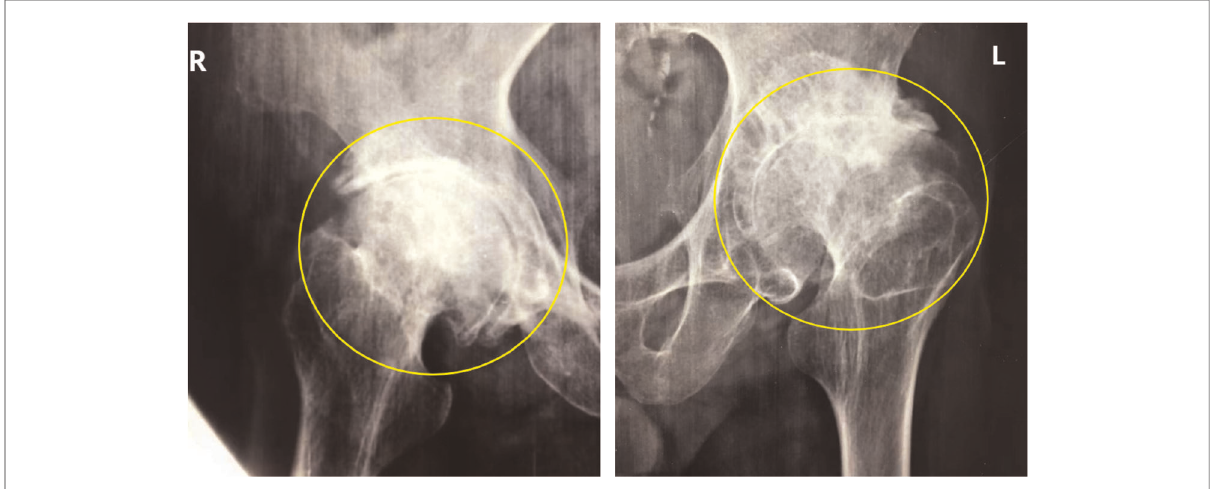
FIGURE 1 The patient ’ s preoperative x-ray of the hip joint. (Figure notes: Circles in the x-ray were marked to show that varying degrees of necrosis of both femoral heads, with a large amount of osteophytes forming around the hip